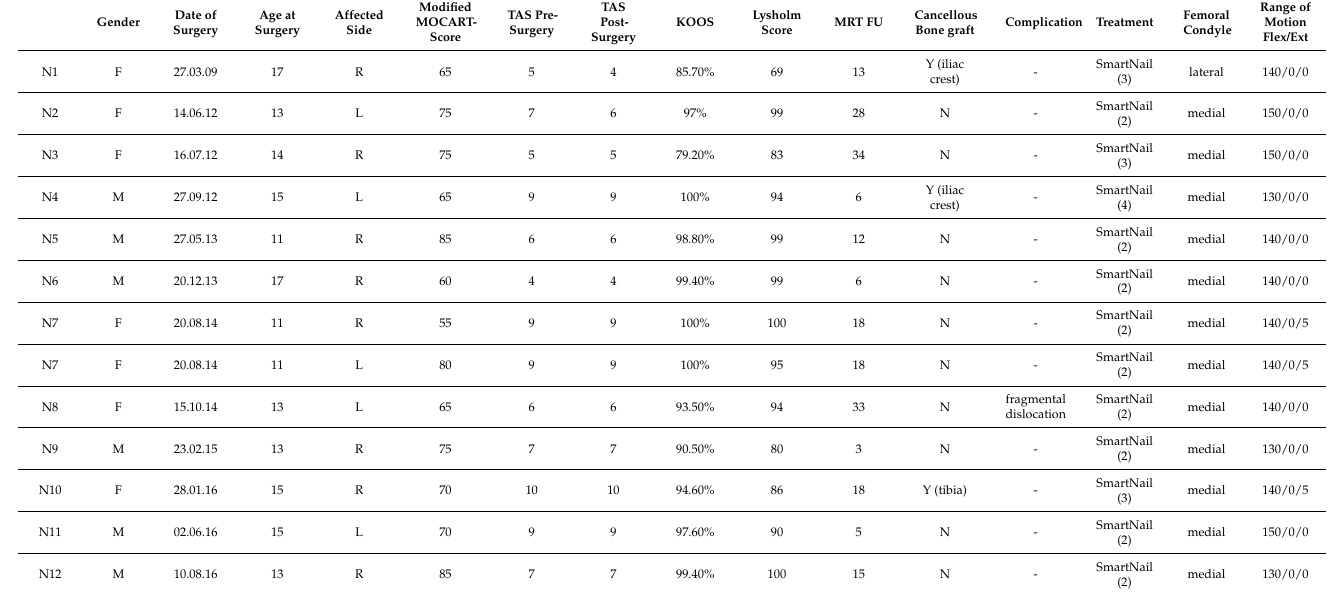
Table 4. Clinical